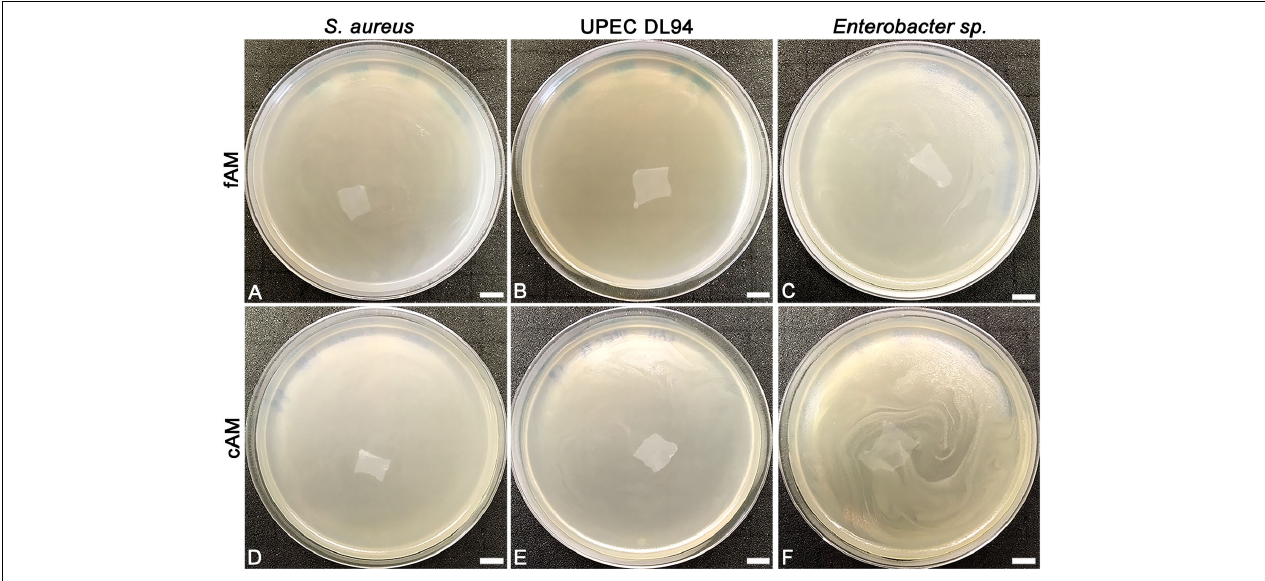
FIGURE 1 | The effect of fresh (fAM) and cAM patches on Staphylococcus aureus , UPEC DL94 and Enterobacter sp. ( A–C ) fAM patches and ( D–F ) cAM patches have no antimicrobial effect on tested strains. These results were obtained by employing antimicrobial efficiency assay with AM patches embedded in soft agar. Three independent replications of experiments using three biological samples were conducted and three technical repeats were performed for each condition. Scale bars: 10 mm.